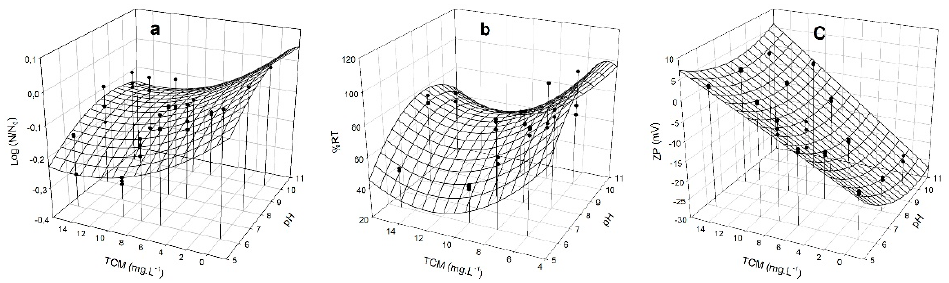
Figure 7. Response surface plot for M. aeruginosa CAAT 2005-3 of: ( a ) log (N/N 0 ); ( b ) %RT removal; and ( c ) ZP of the clarified zone, as a function of different concentrations of TMC (mg L − 1 ) and pHs. (•) experimental measurements.